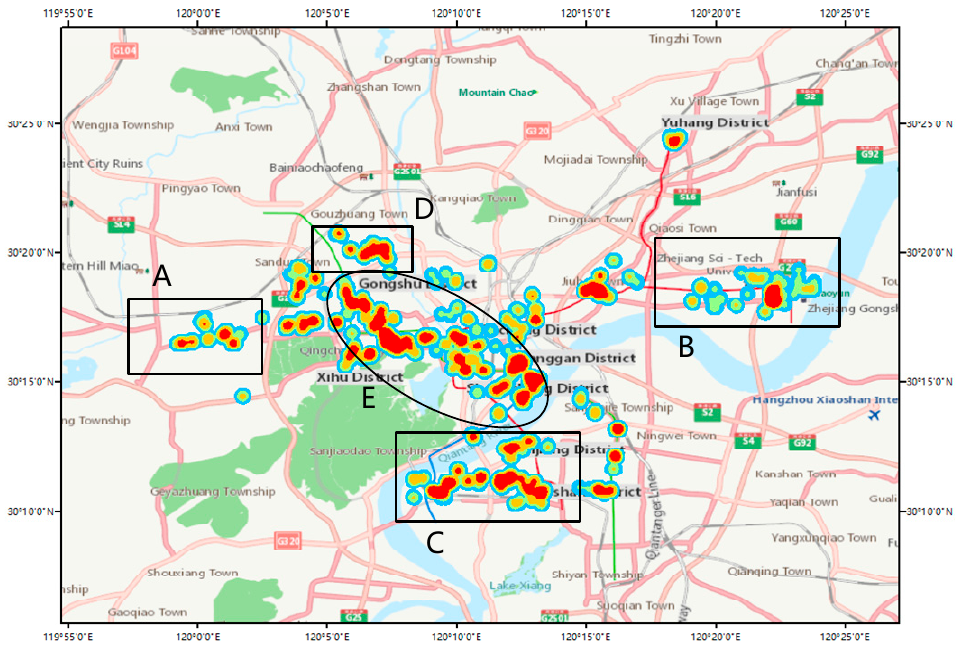
Figure 13. The distribution of high-tech zones and the downtown area in the heat map.